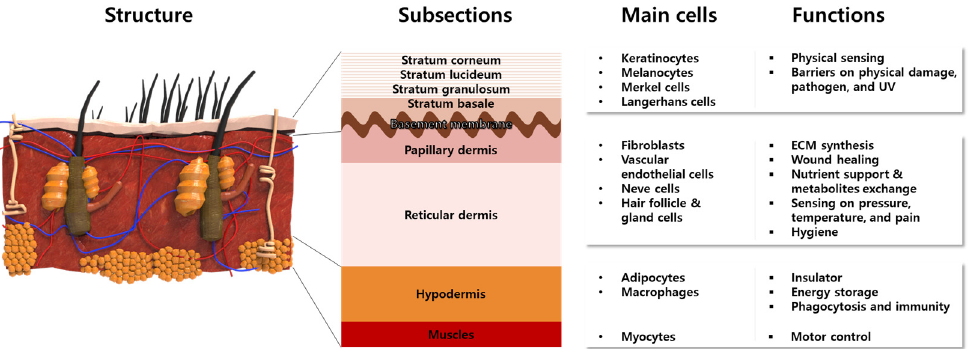
Figure 2. Anatomical structures of multi-layered skin composed of representative cells with intrinsic functions.